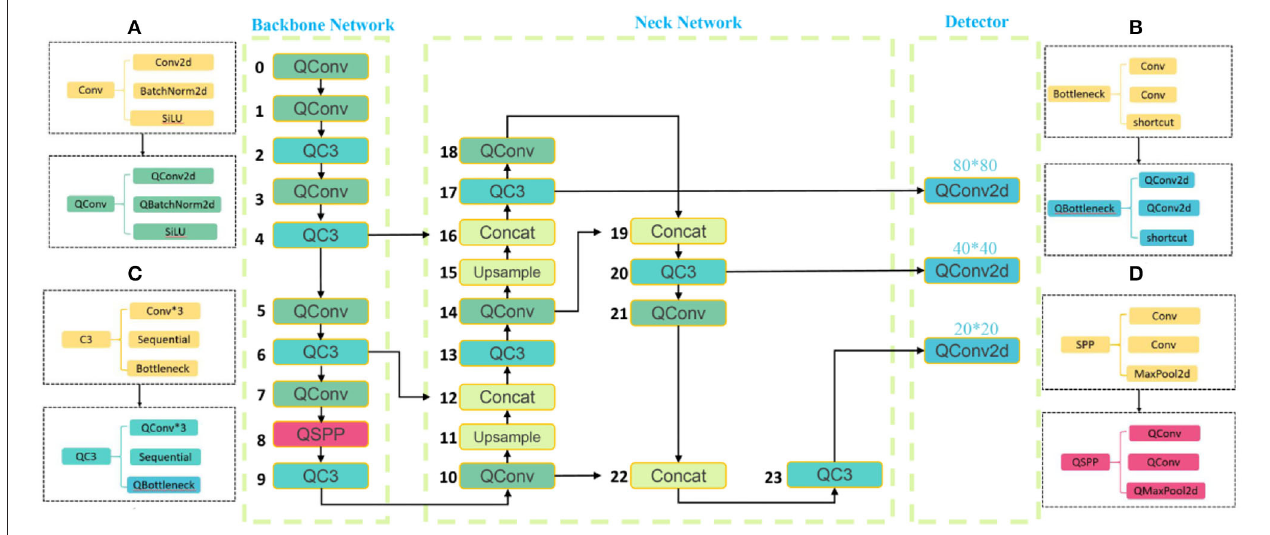
FIGURE 6 | Integration of YOLO V5 model structure using